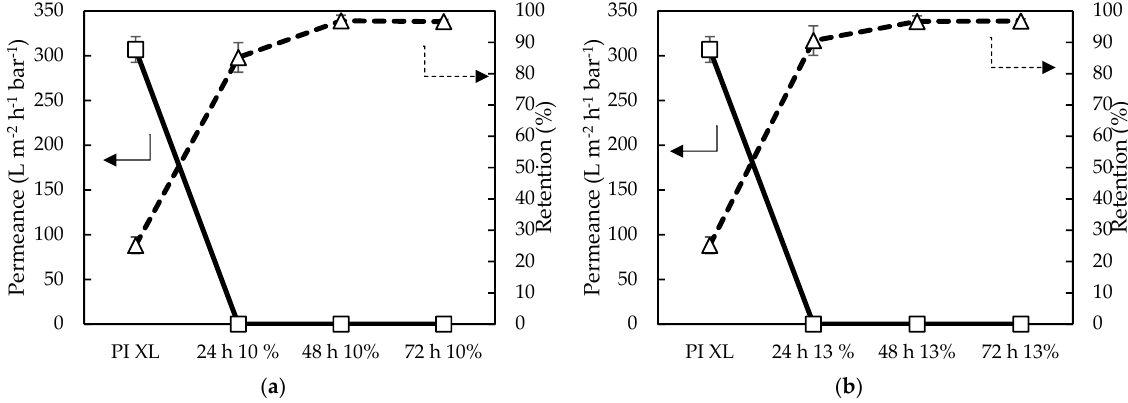
Figure 12. Filtration performance of ( a ) 10 wt% HDA in water with 10 wt% E2 in Aliquat and ( b ) 13 wt% HDA with 13 wt% E2 using a high throughput (HT) membrane filtration for simultaneous screening of 16 membranes at 20 bar and room temperature (RT).